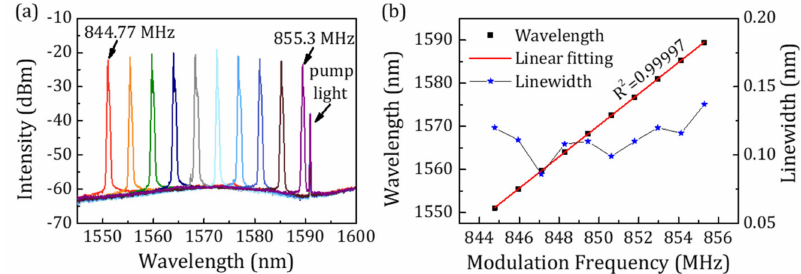
Figure 4. ( a ) Static spectra of the wavelength-swept AML laser based on the XGM. ( b ) Mode locked wavelength (left y axis) and linewidth (right y axis) versus modulation